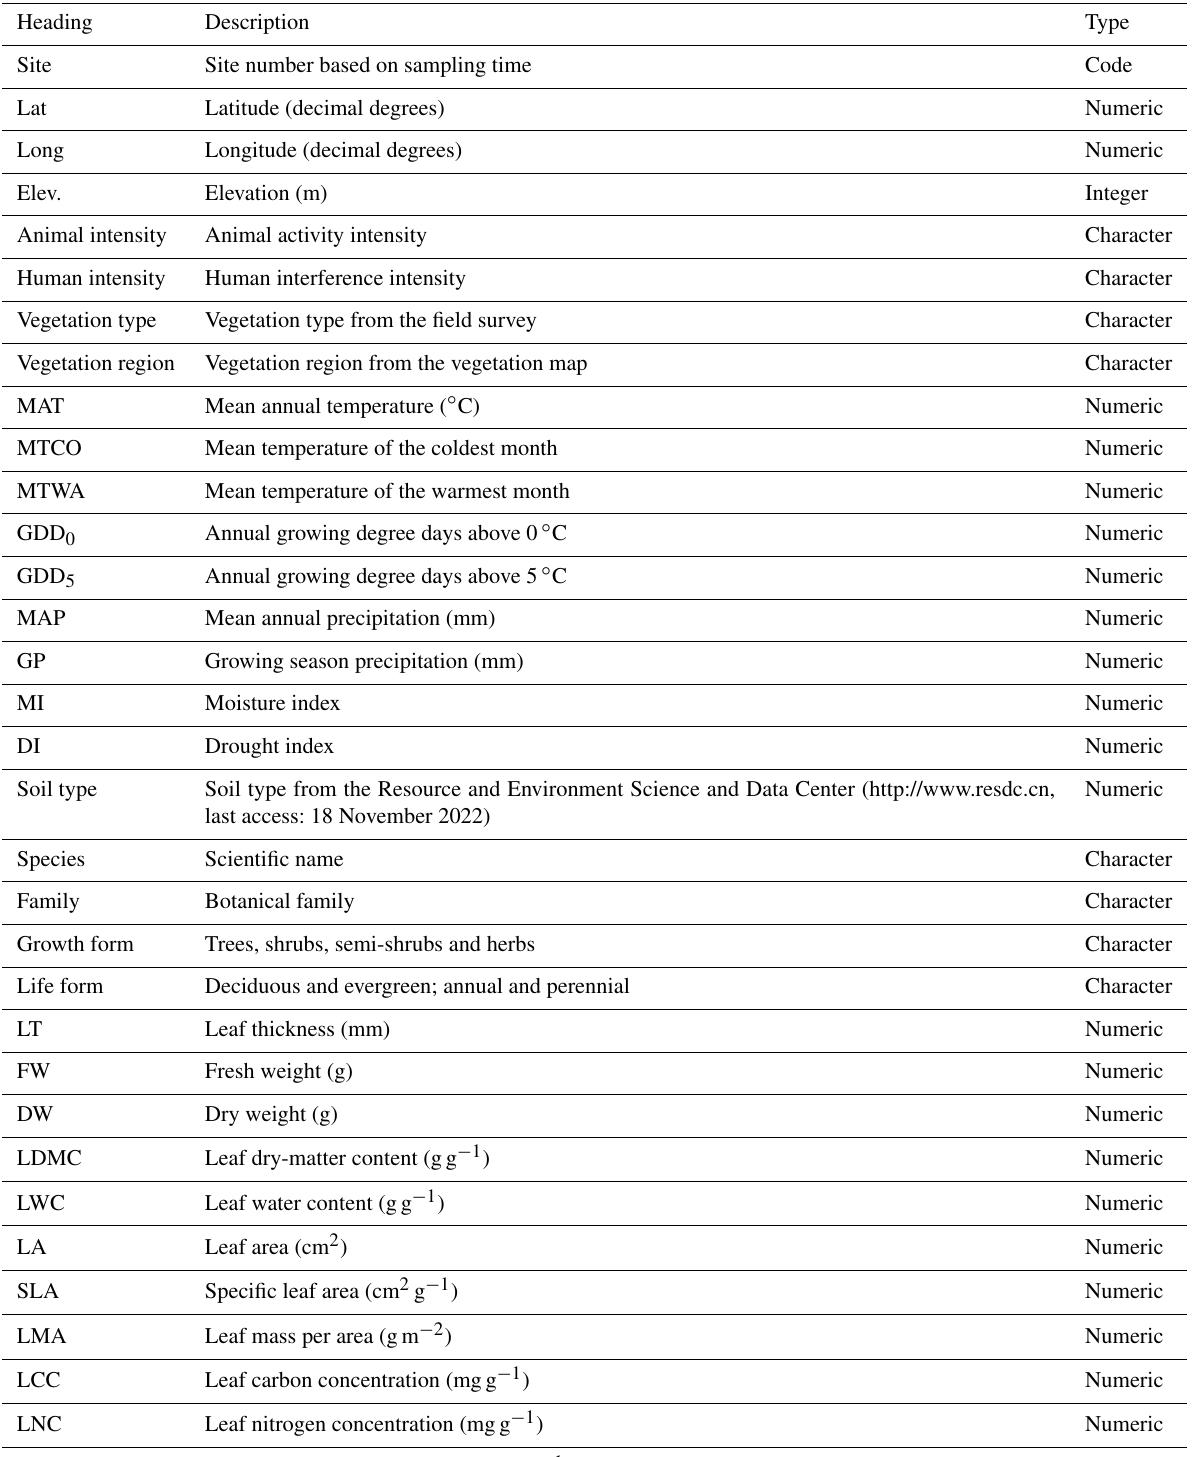
Table 2. Summary information found in the TiP-Leaf